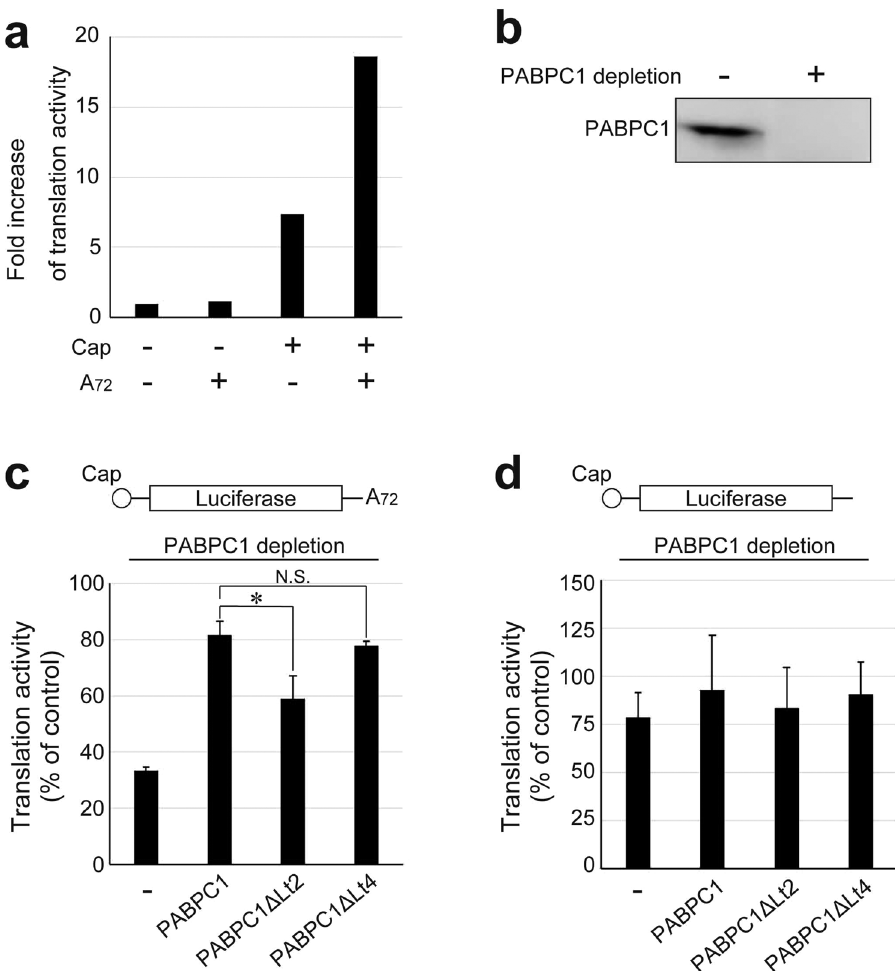
Figure 7. Effects of Lt2 deletion in PABPC1 on cap/poly(A)-dependent translation. ( a ) Translational enhancement by the cap and poly(A) tail. The relative increase of translation activity is shown as the fold increase in the luciferase activity of the mRNA without cap and poly(A). ( b ) Western blotting against PABPC1 for the control RRL and the PABPC1-depleted RRL. The control RRL was treated with GST immobilized glutathione-sepharose beads. The uncropped original blots were shown in Supplementary Figure 6. ( c , d ) Translation activity of the capped luciferase mRNA with ( c ) or without ( d ) poly(A) in the PABPC1-depleted RRL in the presence of the purified PABPC1, PABPC1 Δ Lt2 or PABPC1 Δ Lt4 (10 nM). Translation activity is shown as a percentage of the luciferase activity in the control RRL. The results represent average values and standard deviations in three independent experiments. * and N.S. indicate P < 0.05 and not significant in statistical analysis,